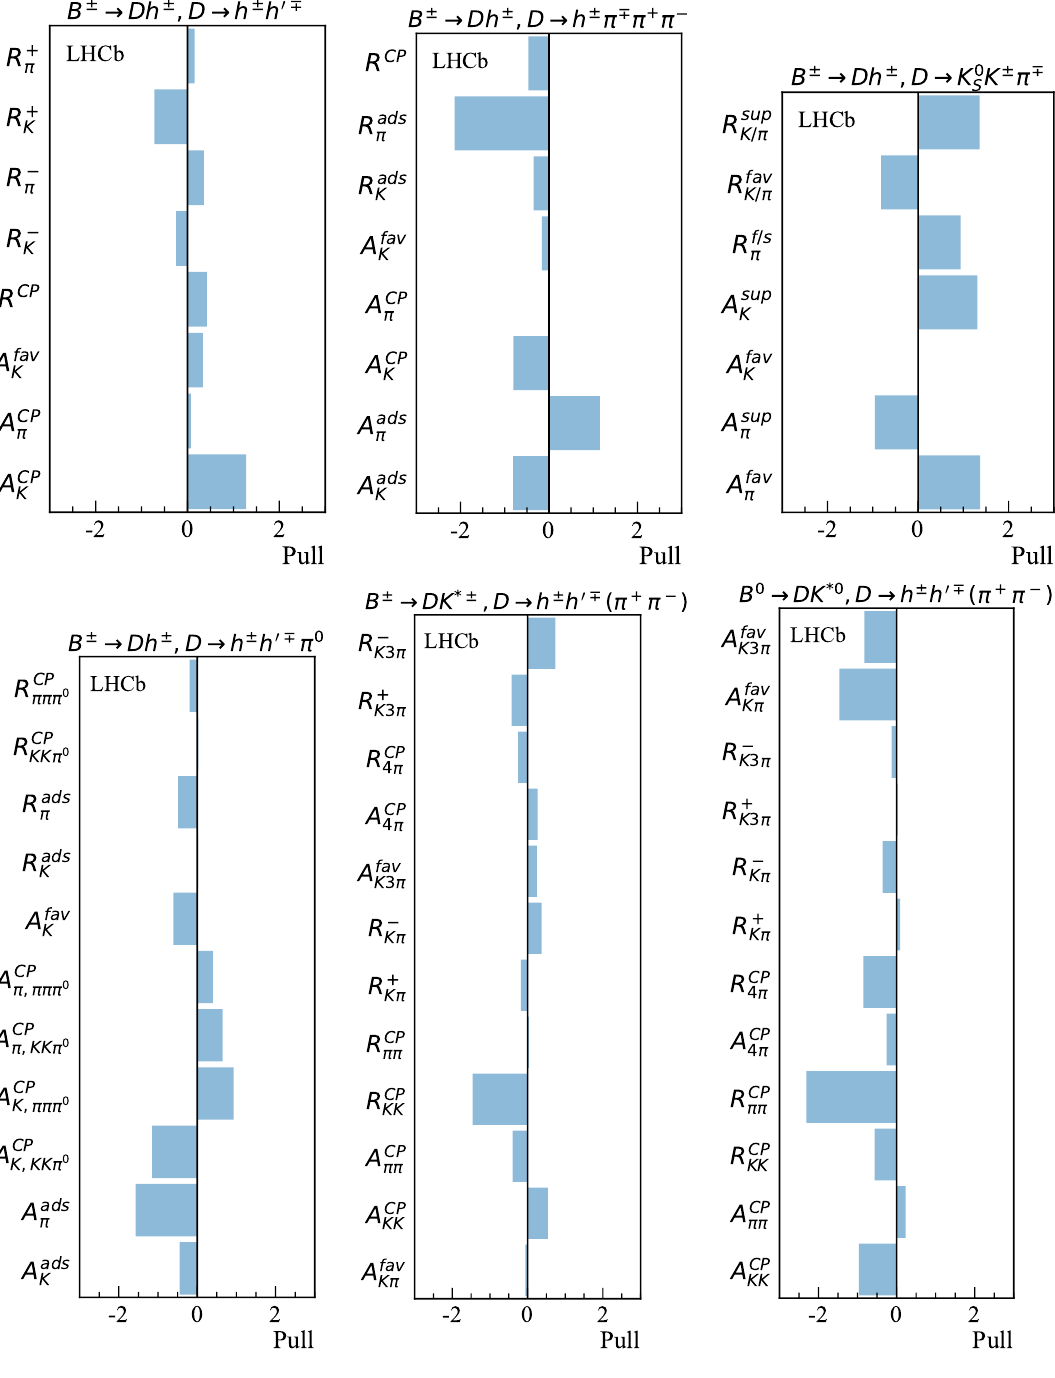
Figure 6 . Pulls of the input observables, part 1 of